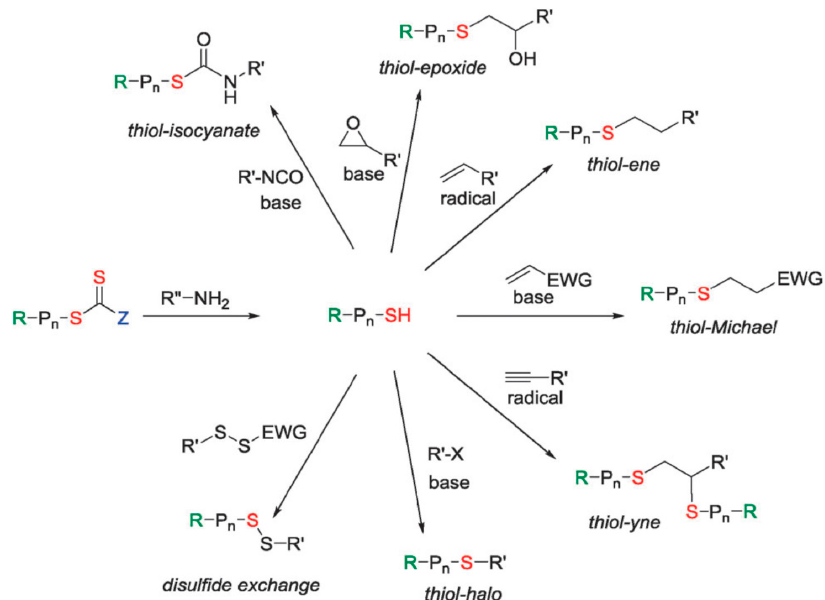
Figure 6. Synthetic strategies to block copolymers (BCPs) using thiol-based coupling reactions. Reprinted from Reference [59]. (Copyright (2014) Royal Society of Chemistry).